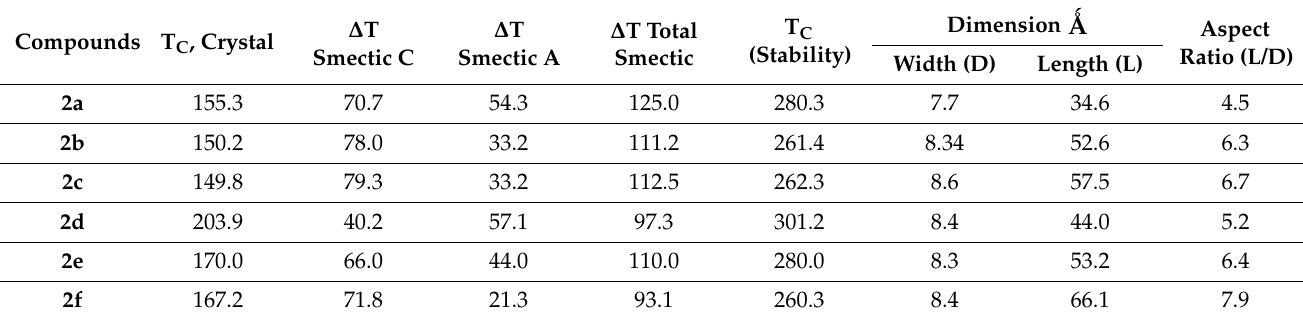
Table 5. Dependence of the aspect ratios of the prepared compounds with mesomorphic behaviours. Compounds T C , Crystal